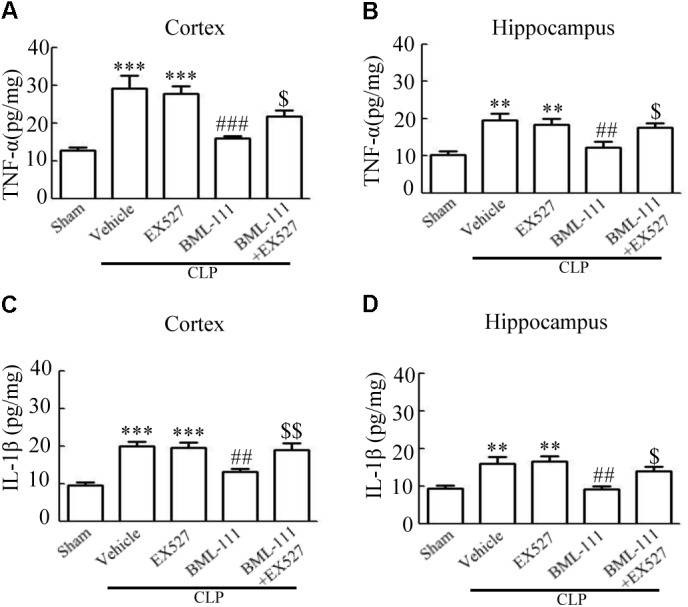
BML-111 inhibits the expression of inflammatory cytokines via SIRT1 in CLP mice. The expression levels of TNF-α and IL-1β were increased significantly in CLP + Vehicle and CLP + EX527 group when compared with sham group in cortex and hippocampus, and there was no difference in CLP + Vehicle group and CLP + EX527 group. BML-111 significantly decreased the levels of TNF-α and IL-1β compared with CLP + Vehicle group. EX527 up-regulated the expression of inflammatory cytokines in the cortex and hippocampus when compared with the CLP + BML-111 group. Data were shown as the means ± SEM (n = 5 surviving mice in A–C, n = 4 surviving mice in D). ∗∗P < 0.01, ∗∗∗P < 0.001 represent CLP + Vehicle vs. Sham and CLP + EX527 vs. sham, ##P < 0.01, ###P < 0.001 represent CLP + BML-111 vs. CLP + Vehicle, $P < 0.05, $$P < 0.01 represent CLP + BML-111 + EX527 vs. CLP + BML-111.